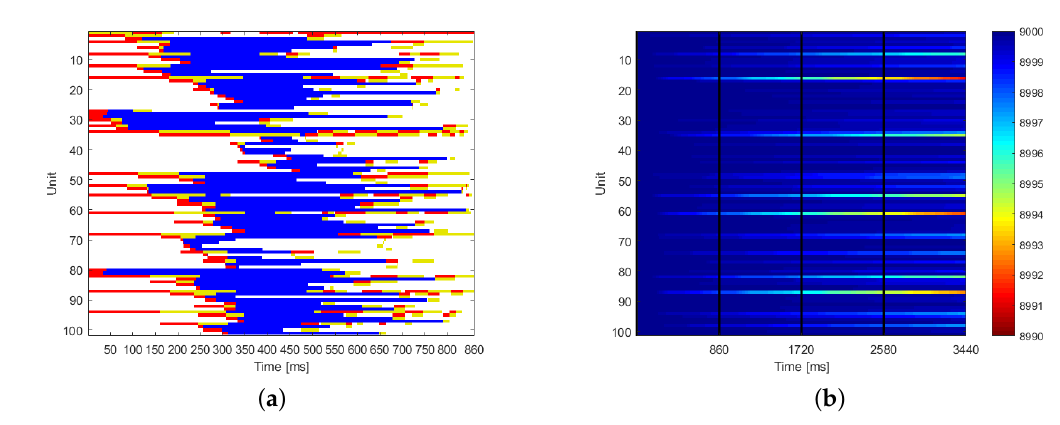
Figure 7. Best solution: scheduling and energy level. ( a ) Scheduling of one elaboration cycle. Red represents the receiving mode, blue the elaboration status, and yellow the transmitting mode. ( b ) Energy level for each sensor in the first five elaboration cycles.